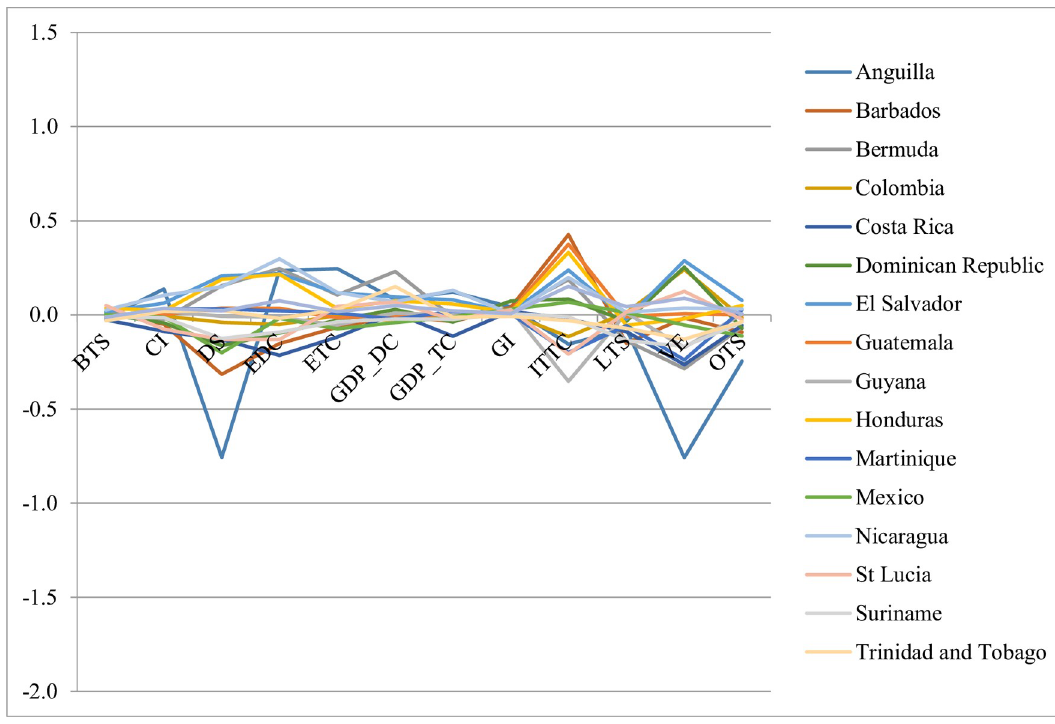
Fig 4. Slopes for 5 th cluster.